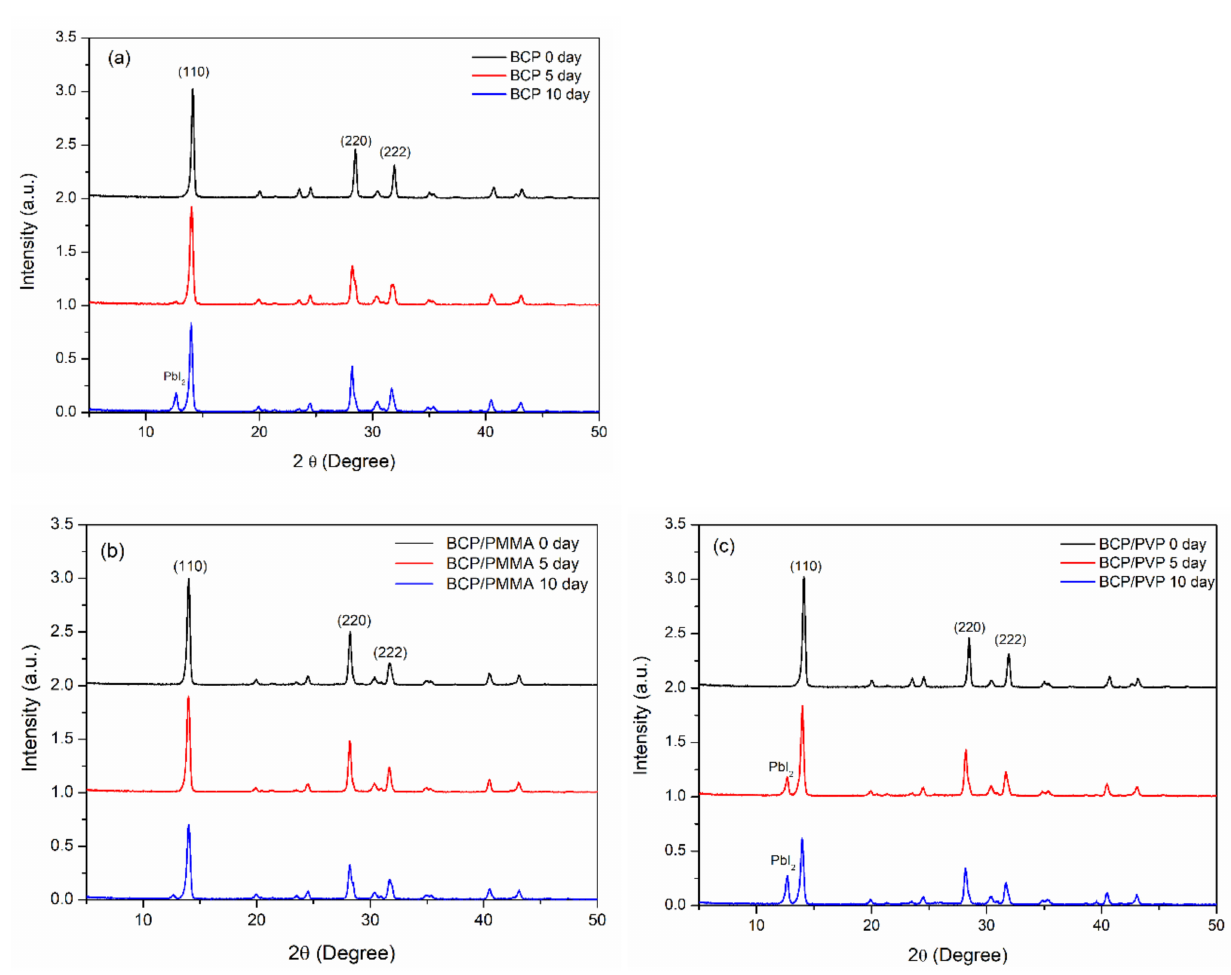
Figure 6. XRD (X-ray diffractometry) patterns of ITO/PEDOT:PSS/MAPbI 3 /PC 61 BM structures coated with hole- blocking/electron-transporting interfacial layers of ( a ) BCP, ( b ) BCP/PMMA (5:1, w / w ), and ( c ) BCP/PVP (5:1, w / w ), recorded after storage at 30 ◦ C and 35% relative humidity for 0, 5, and 10